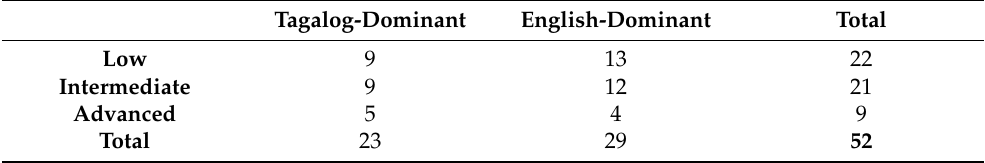
Table 2. Participant groups according to Spanish proficiency and language dominance.